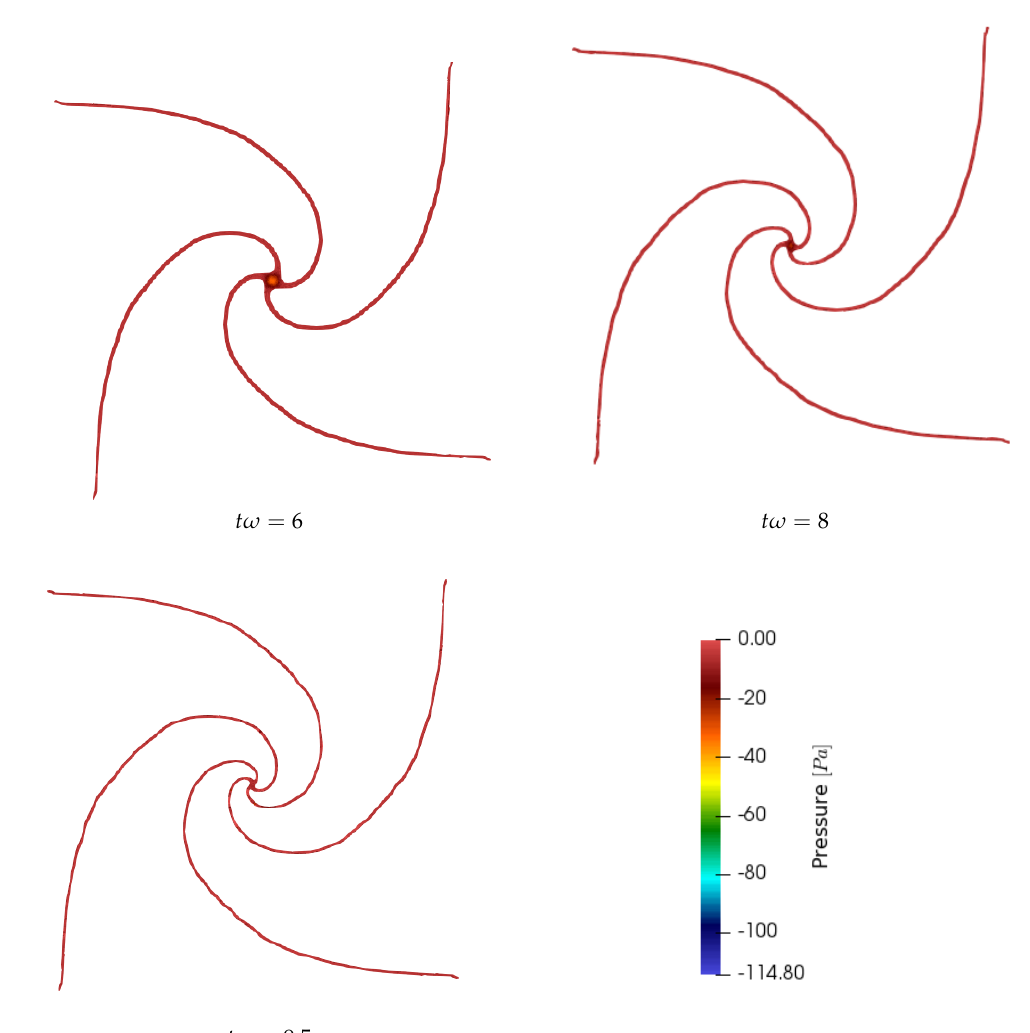
Figure 16. Evolution of an initially-square fluid patch: Pressure field obtained and evolving shape of the square path at dimensionless times t ω = { 6,8,9.5 }